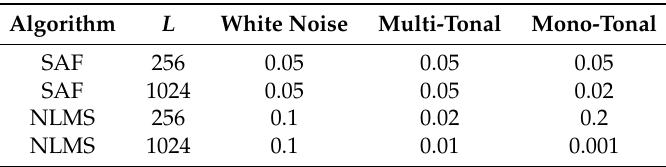
Figure 13. Test case 4: comparison of the noise reduction achieved in an ANC system, where: ( a ) x ( n ) is white noise and filter length is L = 256; ( b ) x ( n ) is multi-tonal noise and filter length is L = 256; ( c ) x ( n ) is mono-tonal noise and filter length is L = 256; ( d ) x ( n ) is white noise and filter length is L = 1024; ( e ) x ( n ) is multi-tonal noise and filter length is L = 1024; ( f ) x ( n ) is mono-tonal noise and filter length is L = 1024; Halfway through the simulation the secondary path changes suddenly. The legend is the same for all sub figures Table 6. Adaptation step size used in test case